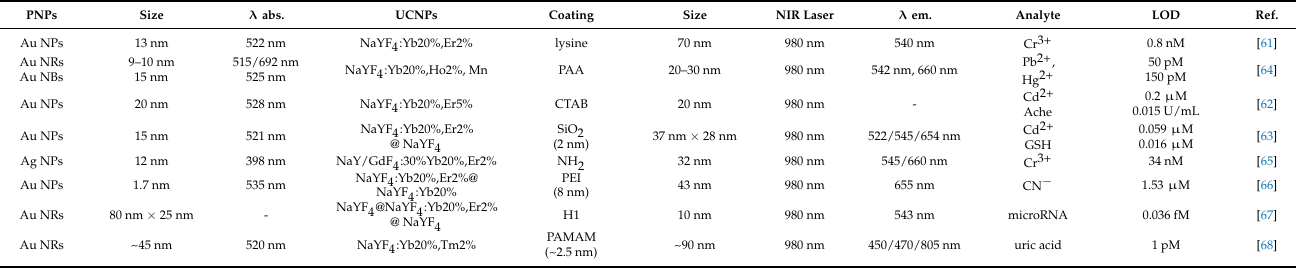
Table 3. Photon-modulated upconversion nanoparticles (PNPs—plasmonic nanoparticles, — upconversion nanoparticles, λ abs.—emission wavelength, NIR—near-infrared, λ